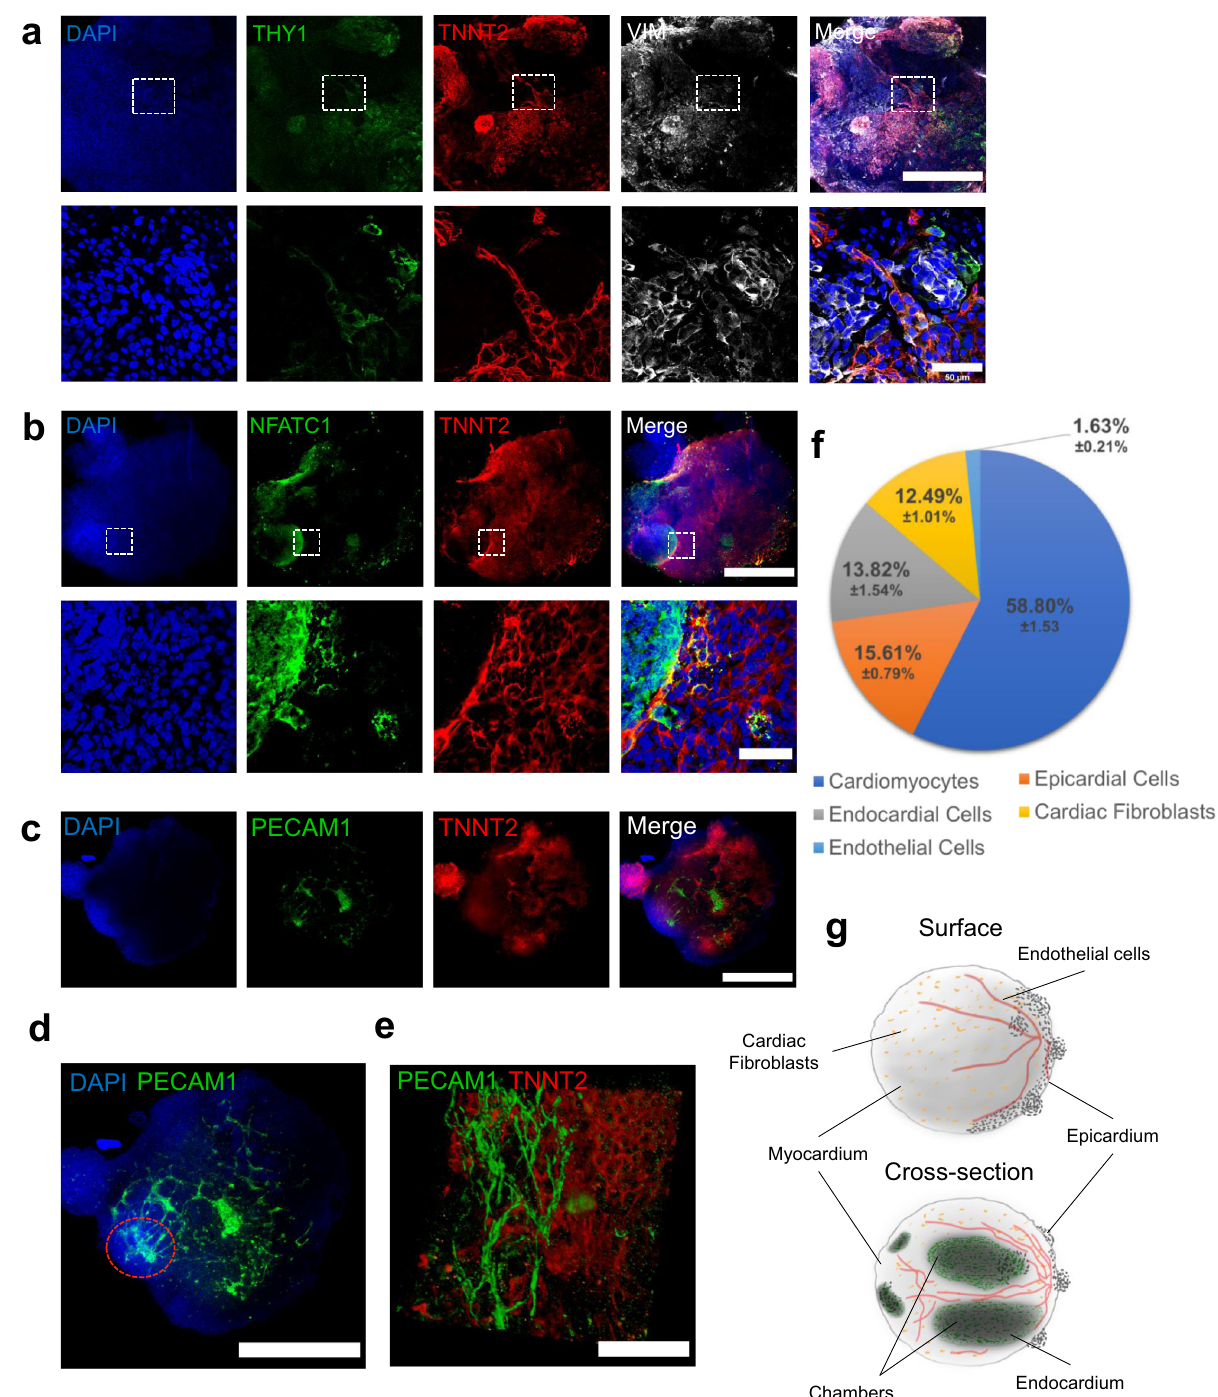
Fig. 3 hHO cardiac cell lineage composition. a – e Immuno fl uorescence images of various cell lineages composing the hHOs. a , Cardiac fi broblast markers THY1 (green) and VIMENTIN (white) present throughout the hHOs, TNNT2 (red), DAPI (blue); scale bar: 500 µ m, inset: 50 µ m. b Endocardial marker NFATC1 (green) highly expressed within chambers of TNNT2 + tissue (red); scale bar: 500 µ m, inset: 50 µ m. c – e Endothelial marker PECAM1 (green) showing a de fi ned network of vessels throughout the organoid and adjacent to TNNT2 + tissue (red), DAPI (blue); showing a single confocal plane ( c ), a maximum intensity projection to visualize the vascular network throughout the organoid ( d ), and a high magni fi cation 3D reconstruction showing tubular endothelial structures ( e ); red dotted circle in ( d ) indicates area of high vascular branching. Scale bar: c , d : 500 µ m, e 50 µ m. f Pie chart of average cell composition in hHOs, calculated as the percentage of cells with respective cell marker over all cells by nuclei counting using ImageJ. g Sketch of hHO surface (top) and cross-section (bottom) showing the organization of cell types and features of the hHOs. Source data are provided as a Source Data fi